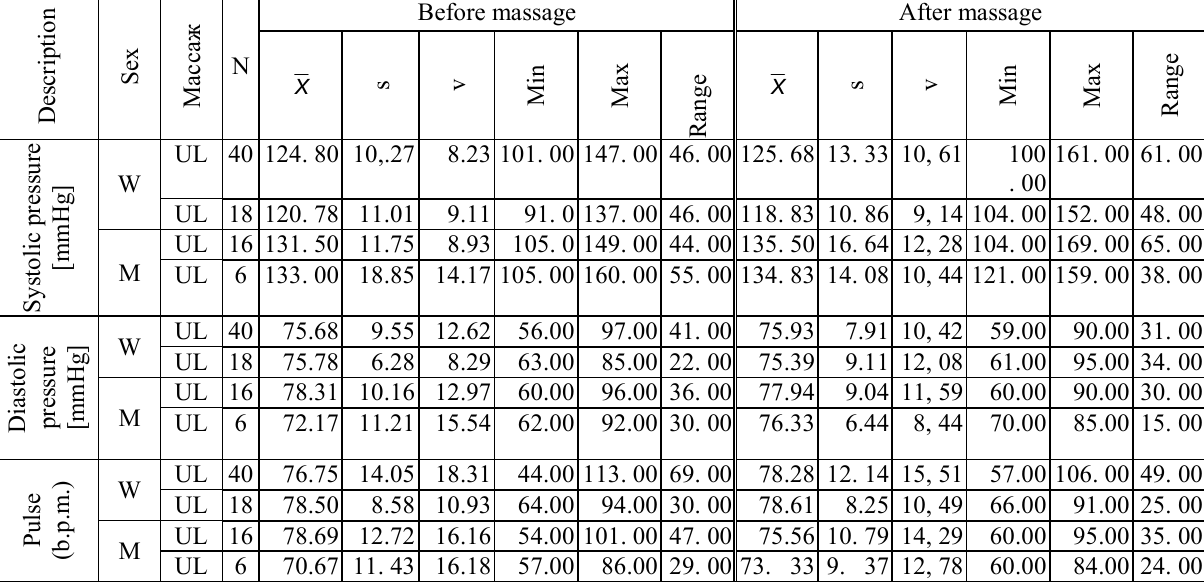
Statistical characteristics of haemo-dynamic indicators, which were examined by criteria: different massages and